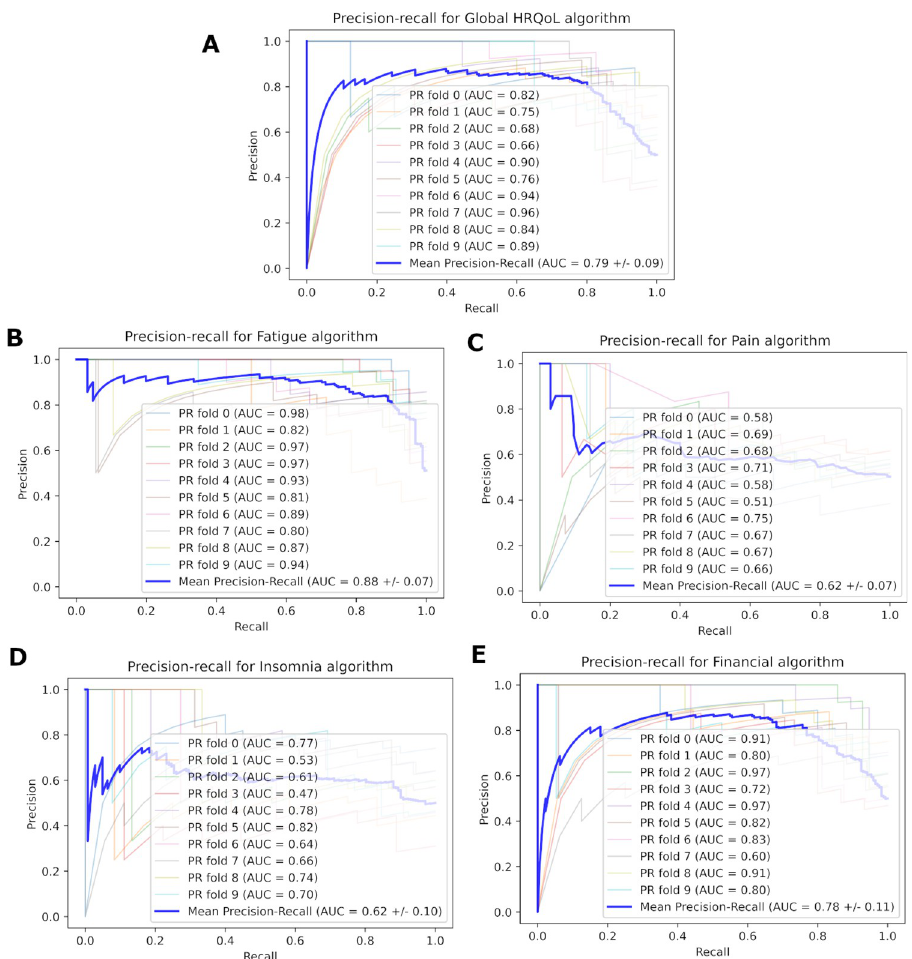
Fig 3. Precision-recall curve of the best performing algorithm for the five most prevalent outcome measures in the dataset.